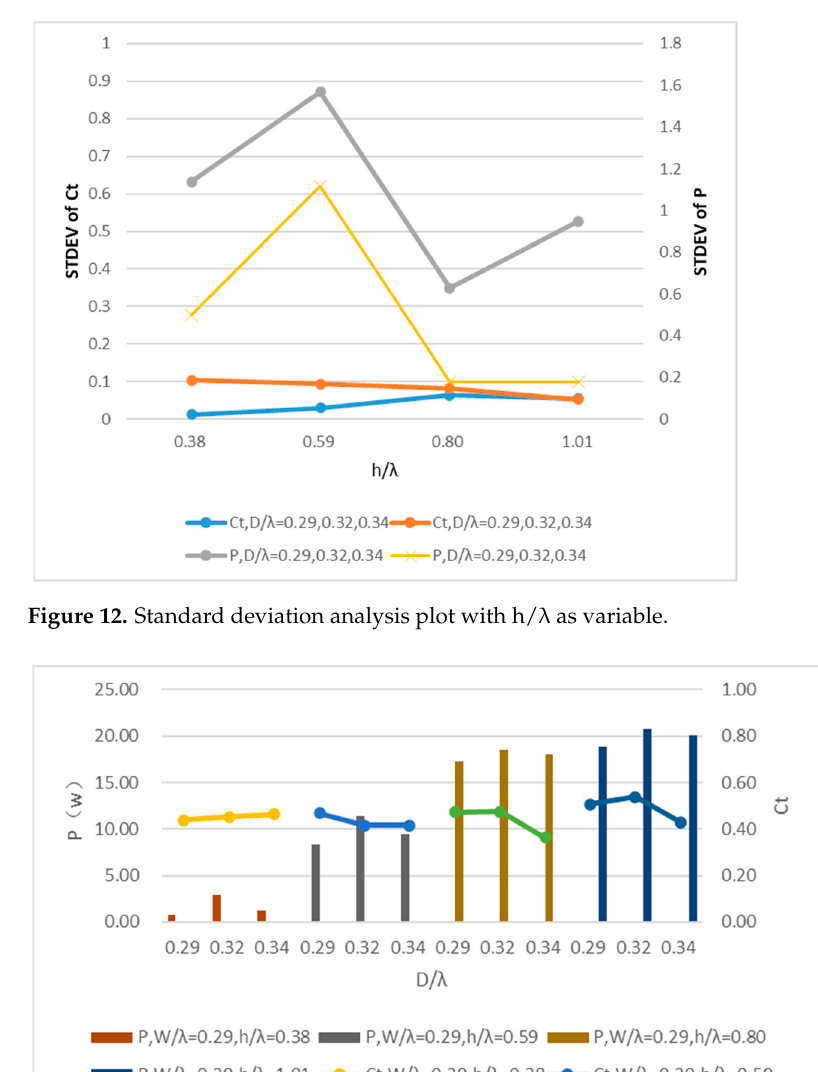
Figure 12. Standard Deviation Analysis Chart.